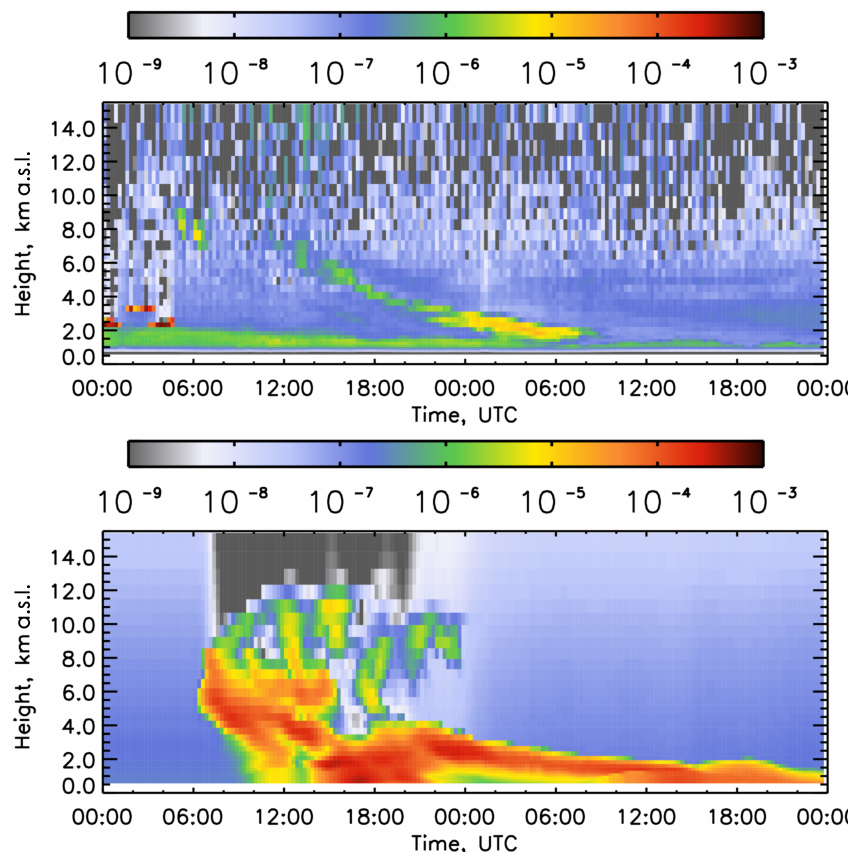
Figure 13. Attenuated backscatter coefficient of ceilometer (top) and forward model (bottom) at Deuselbach station in Germany from 16 April 2010, 00:00UTC, to 17 April 2010, 24:00UTC, given in units of m − 1 sr − 1 . The ACL measurements in heights above 8kma.s.l. are strongly affected by noise which limits the comparability of both data sets. A comparison of samples near the ground is limited by the missing overlap correction of ACL data and the lack of background aerosol prediction data. The ash layers in heights between 2 and 8kma.s.l. allow for identifying similar and non-similar structures of measurement and forward-modeled COSMO-ART predictions of the Eyjafjallajökull ash. The maximum value of the (non-calibrated) ACL-measured attenuated backscatter coefficient is by about 1 order of magnitude lower than the attenuated backscatter coefficient from COSMO-ART prediction with BaLiFOp